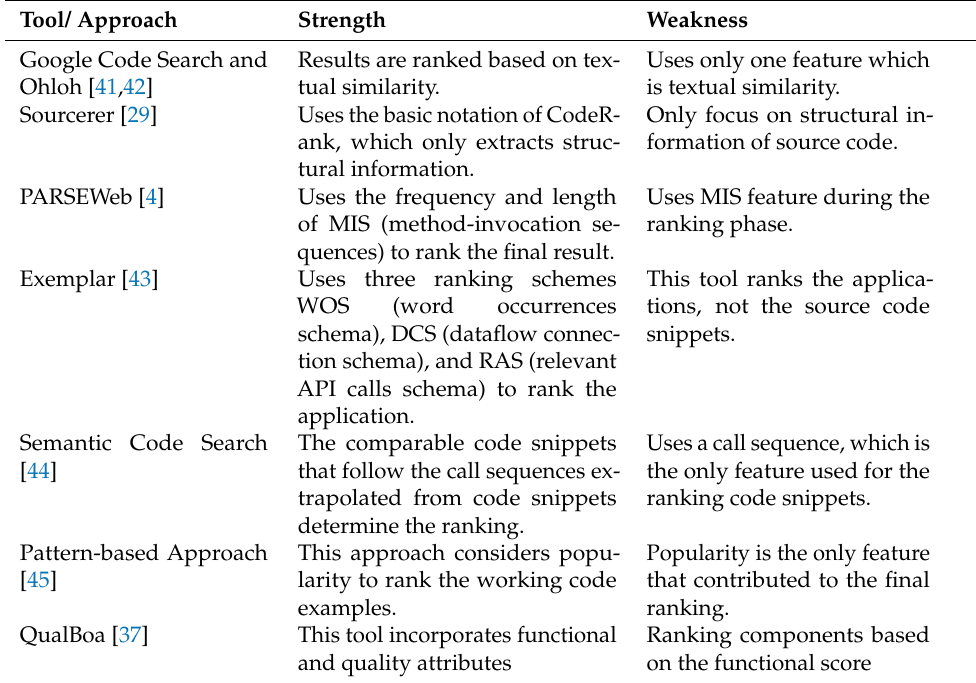
Table 2. Ranking approaches for source